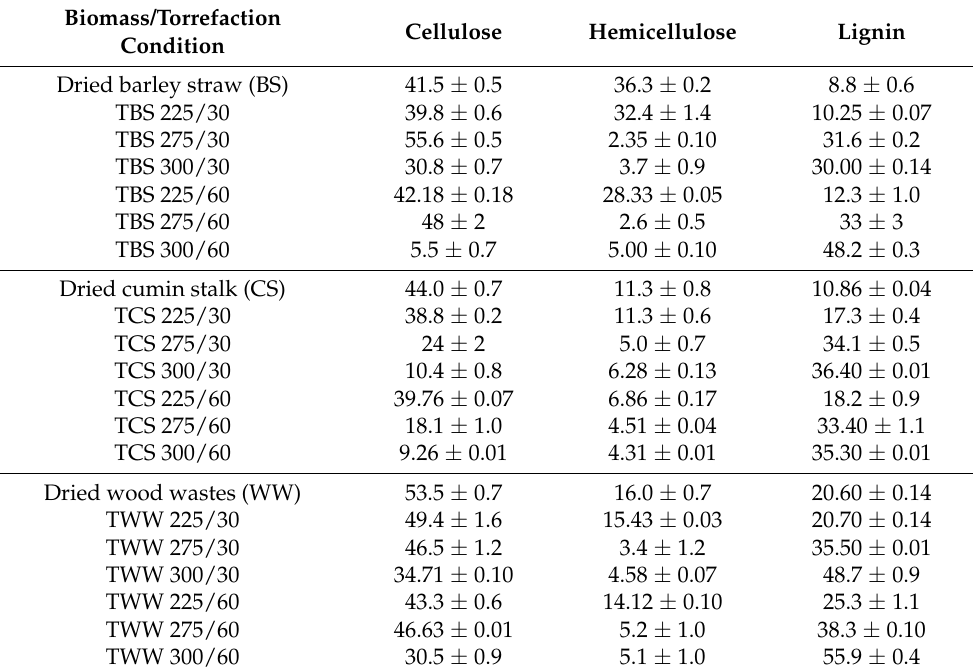
Table 2. Chemical composition of biomass before and after torrefaction